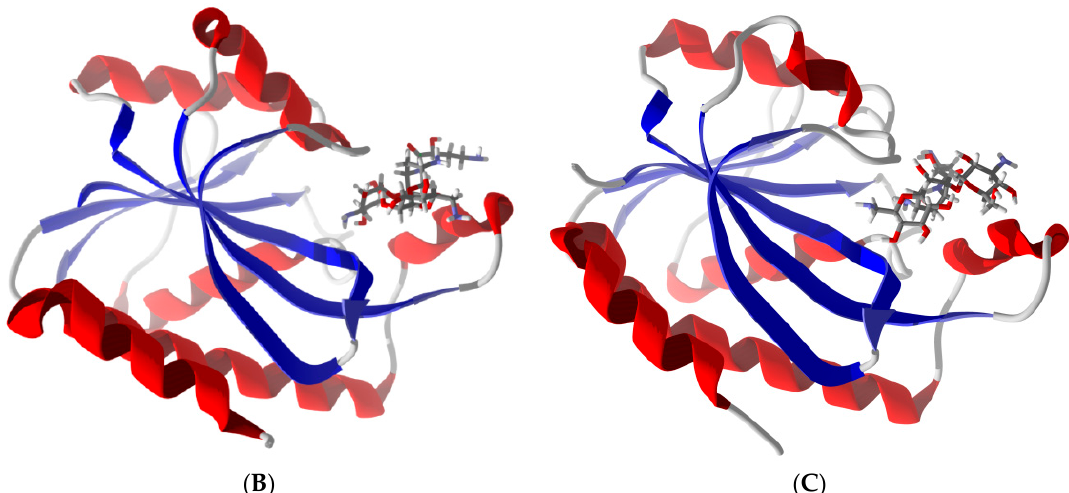
Figure 2. ( A ) Lowest-energy docked poses of phenylacetamide-substituted β -lactam antibiotics with E. coli Pth1 (PDB 2PTH): Ampicillin (aqua), cefaclor (orange), cefadroxil (pink), cefamandole (green), cefprozil (yellow), and cephalexin (lavender). The benzyl moieties of the docked ligands are sandwiched between His113 and Leu95 of the protein binding site. ( B ) Lowest-energy docked poses of amikacin with E. coli Pth1 (PDB 2PTH) and with ( C ) A. baumanii Pth1 (PDB 4FOP). Table 1. MolDock docking energies (re-rank scores, kJ/mol) for antibiotic ligands.